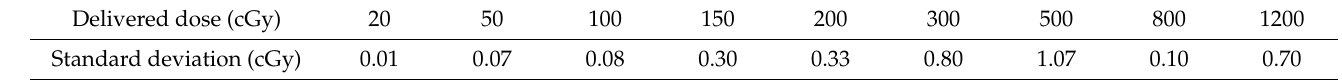
Figure 4. Relationship between the signals of the copper indium gallium selenide (CIGS) solar cell and doses delivered using 6 MV photon beams. Total signal intensity is the sum of the obtained signals from the CIGS solar cell during irradiation. The normalizations were performed based on the signal corresponding to a dose of 1200 cGy. Error bars denote the standard deviations between three repeated measurements. Table 2. Standard deviations between repeated three measurements for linearity evaluation.